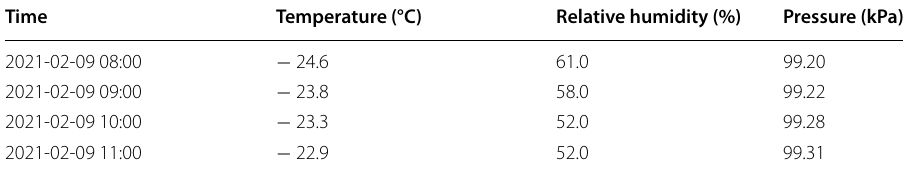
Table 2 Sample of weather data